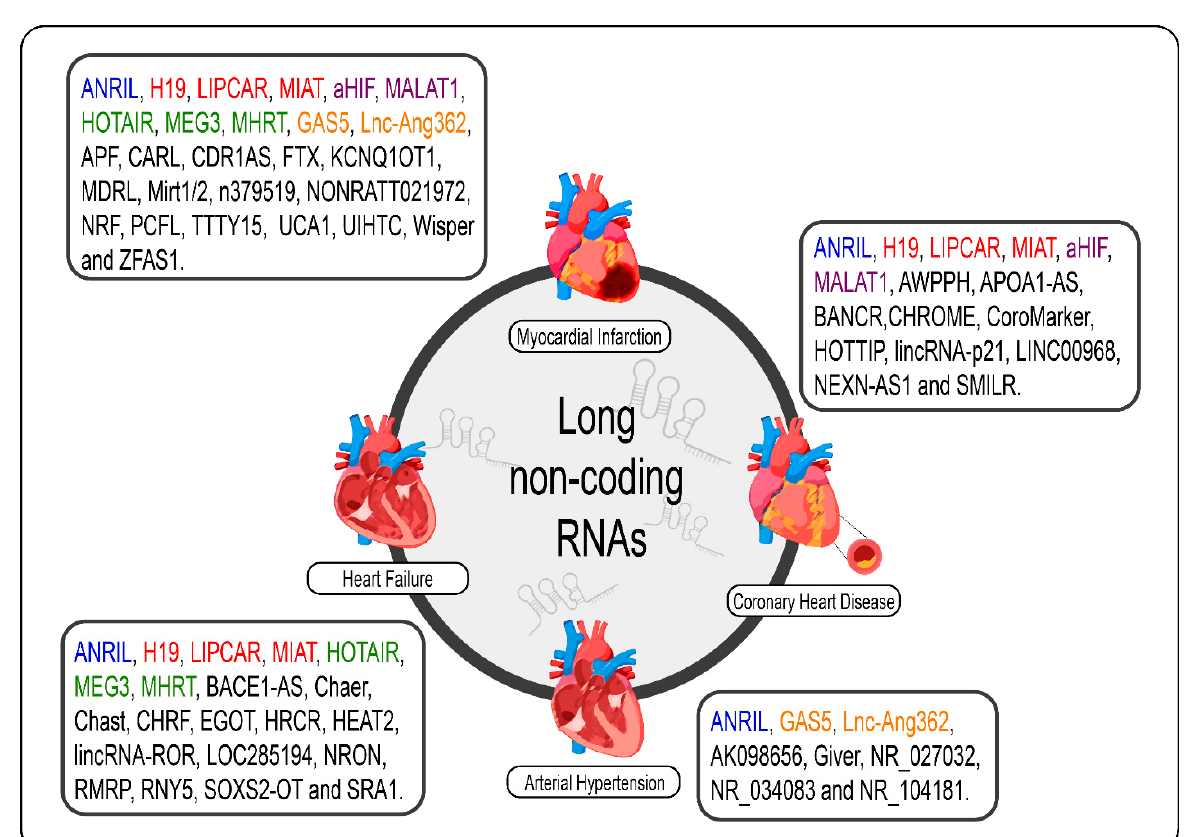
Figure 2. lncRNAs are differentially expressed in cardiovascular diseases such as heart failure, myocardial infarction, coronary artery disease, and arterial hypertension. The lncRNAs marked in blue are the same present in myocardial infarction, coronary artery disease, heart failure, and arterial hypertension; those marked in red are the same present in myocardial infarction, coronary artery disease, and heart failure; those marked in green are the same present in myocardial infarction and heart failure, those marked in orange are present in myocardial infarction and arterial hypertension; and the purple present in myocardial infarction and coronary artery disease.